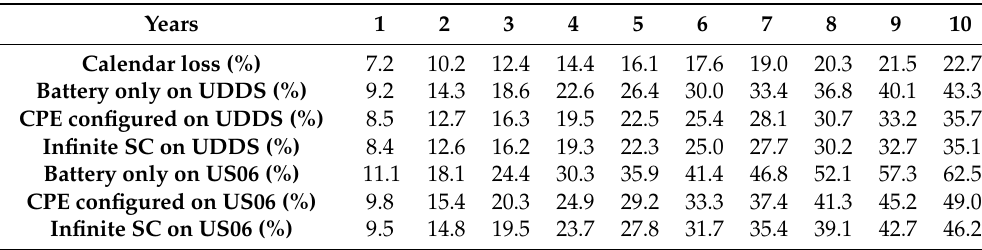
Table 8. Battery degradation percentage over vehicle